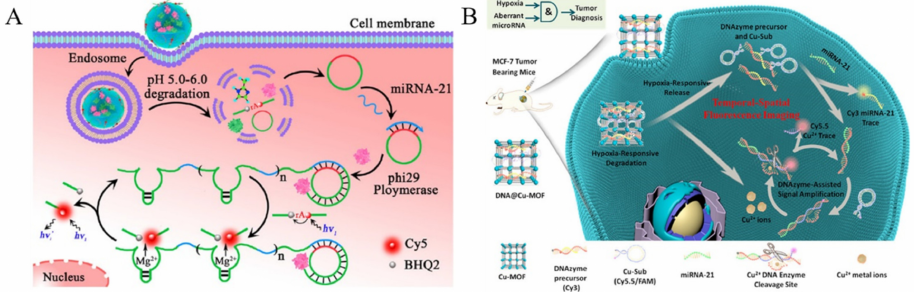
Figure 13. ( A ) Schematic illustration of the intracellular RCA by Using ZIF-8 NPs as a nanocarrier for codelivery of φ 29 DNA polymerase and DNA probes for miRNA-21 imaging in vivo. Reproduced with permission [184]. Copyright 2019, American Chemical Society. ( B ) Schematic illustration of hypoxia-responsive DNA@Cu-MOF nanoprobes for aberrant miRNA and hypoxic tumor imaging using Cu 2+ self-powered DNAzyme-assisted amplification. Reproduced with permission